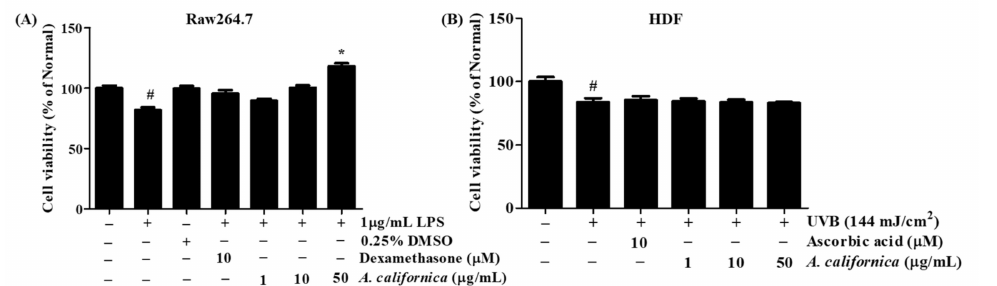
Figure 2. Effect A. californica extract on cell viability of Raw264.7 ( A ) and human dermal fibroblast (HDF) ( B ) cells. Data are presented as the mean ± SD. # and * indicate significant differences from the non-treated cells and induced groups, respectively. # p < 0.05 vs. the non-treated group. * p < 0.05 vs. the induced